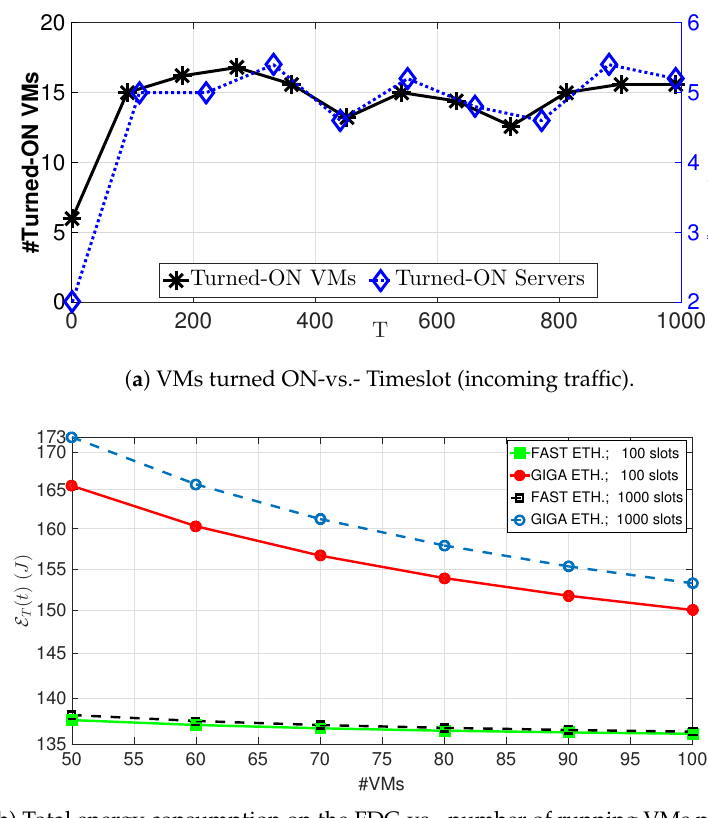
Figure 6. ( a ) Behavior time in relation to the number of turned ON VMs and physical servers, and ( b ) the average total energy in T = 1000,